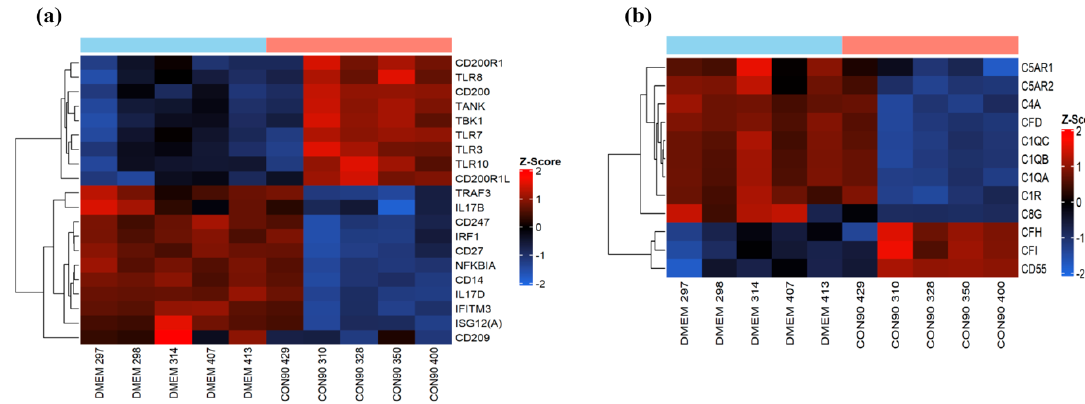
Figure 4. Genes involved in innate immune pathways. Hierarchical clustering analysis of gene expression profile. Each column represents one pig with given treatment and each horizontal line refers to a gene. The associated dendrogram is shown on the left of the heat map. Color legend is on right of the figure. Red indicates genes with increased expression, while blue indicates genes with reduced expression relative to the geometrical means. ( a ) Heatmap showing gene expression profile of innate immune genes; ( b ) heat map showing the profile of differentially expressed genes involved in complement pathways.